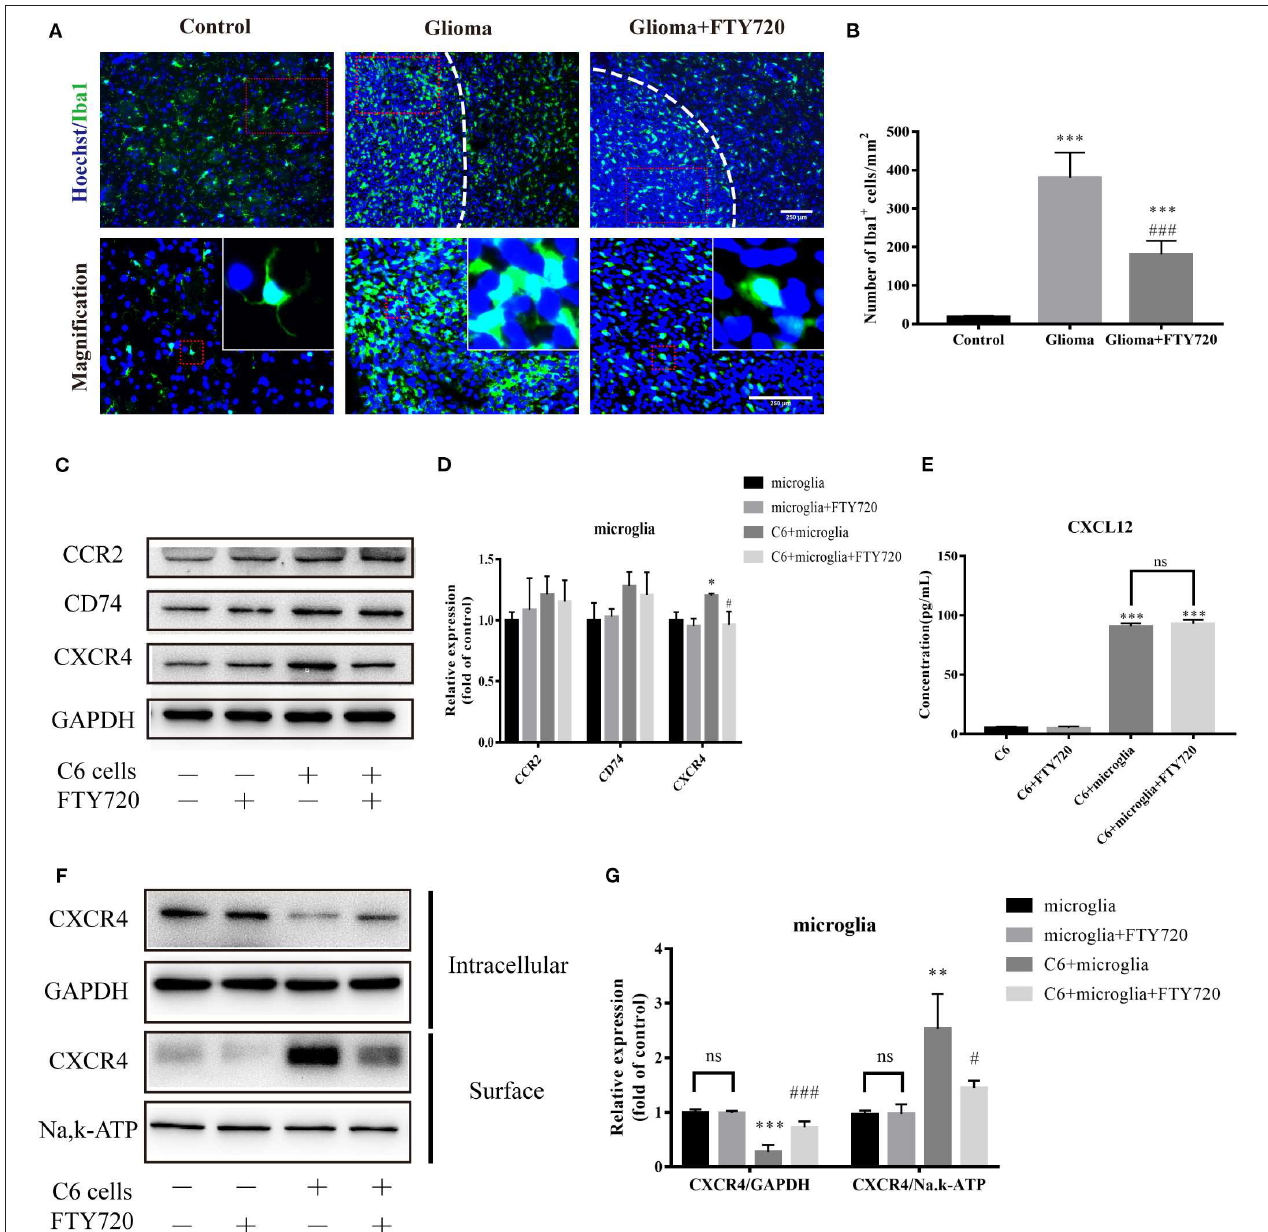
FIGURE 2 | FTY720 blocks the chemoattraction of GAMs via internalizing CXCR4. (A,B) Representative immunostaining and analysis of Iba1-positive cells in the brain sections. Upper and lower panels show lower (20 × ) and higher (40 × ) magnifications, respectively. Data are presented as mean ± SEMs, n = 5–6. *** p < 0.001 vs. Control, ### p < 0.001 vs. Glioma. (C,D) Quantitative Western blotting analysis of the whole protein levels of CCR2, CD74, and CXCR4. (E) The concentration of CXCL12 in the cell culture supernatants. (F,G) The intracellular and cell-surface CXCR4 is analyzed by Western blots. Data are presented as mean ± SEMs, n = 3 for WB and n = 4 for ELISA assays. * p < 0.05 vs. microglia, ** p < 0.01, *** p < 0.001 vs. microglia, # p < 0.05, ### p < 0.001 vs. C6 +